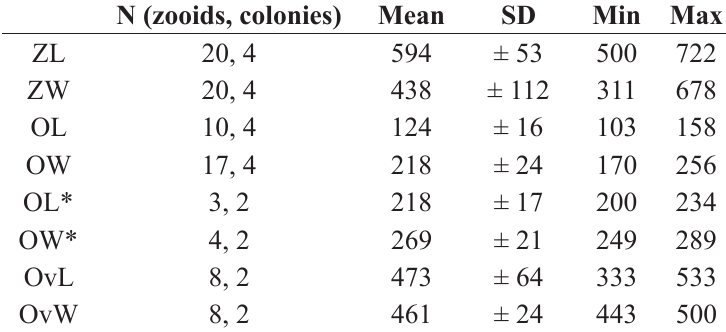
Table 2. Measurements in microns of Powellitheca labiosa gen. et sp. nov. N (zooids,